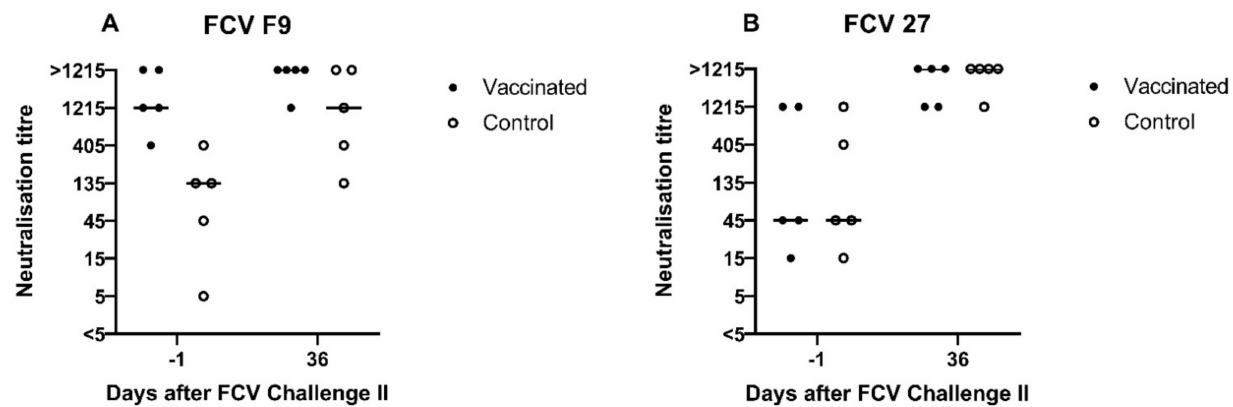
Figure 14. Dot plots of FCV F9 ( A ) and FCV 27 ( B ) neutralisation titres measured by serum neutralisations assays before and after FCV Challenge II with FCV 27. Each dot represents the titre of a cat of the vaccine or control group, respectively. The titre is the reciprocal of the serum dilution where 50% or more of the wells show a CPE. The horizontal bar represents the median. Table 3. Endpoint neutralisation titres of cats of the vaccine and the control group, respectively. The titre is the reciprocal of the serum dilution where 50% or more of the wells show a